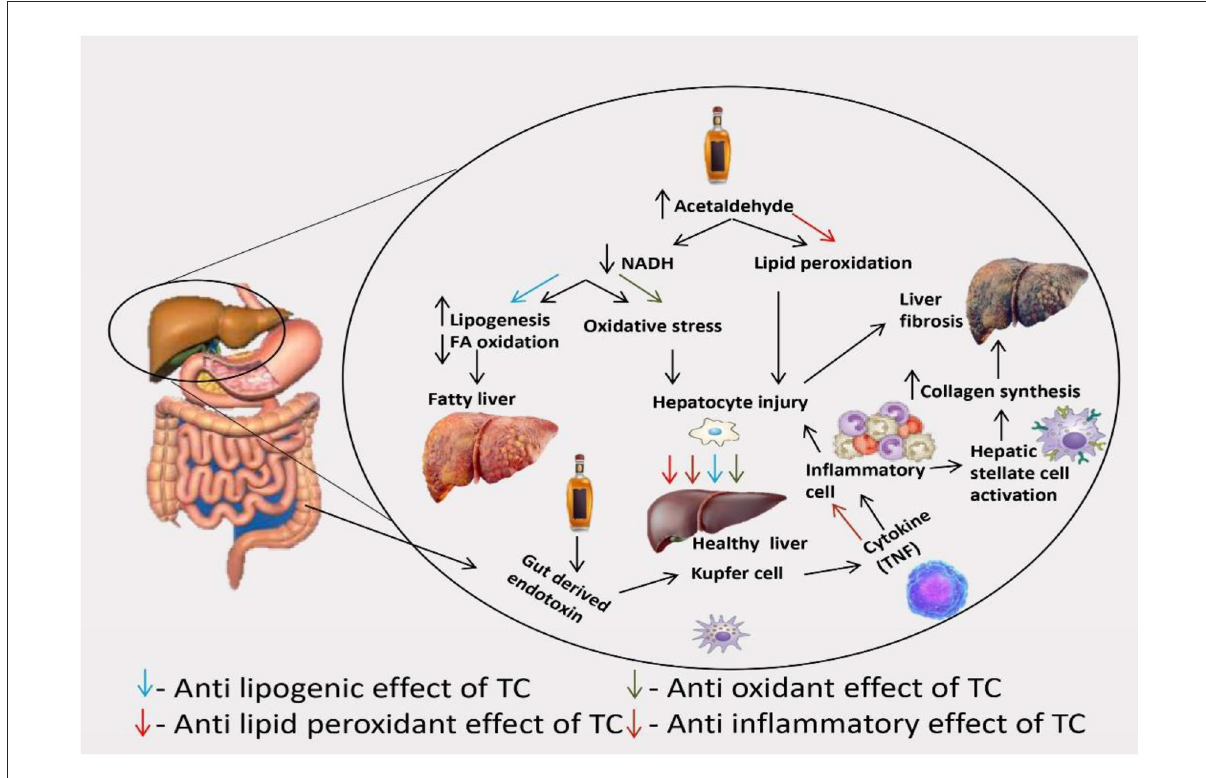
FIGURE11 Mechanism of action of TC in management of alcohol-induced